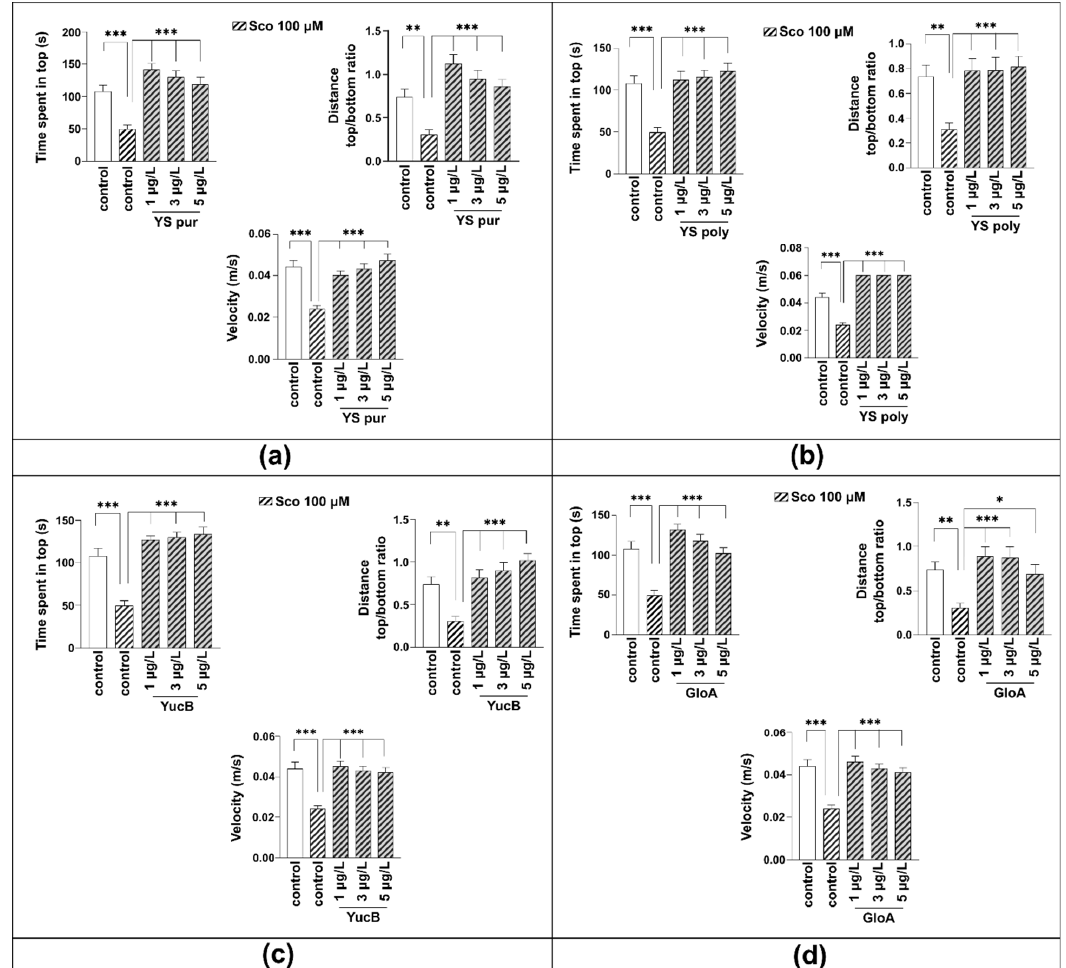
Figure 4. The influence of Y. schidigera preparations in scopolamine (Sco)-treated zebrafish on locomotor activity and anxiety level observed in the Novel Tank Diving Test (NTT). Anxiety response: time spent in the top (s); Locomotion: distance top/bottom ratio; and Velocity (m/s) in the control group; group treated with Sco 100 μ M; groups treated with Sco (100 μ M) and yucca preparations at 1, 3, 5 μ g/L: ( a ) YS pur—purified fraction; ( b ) YS poly—polymeric fraction; ( c ) YuB—Yuccaol B;